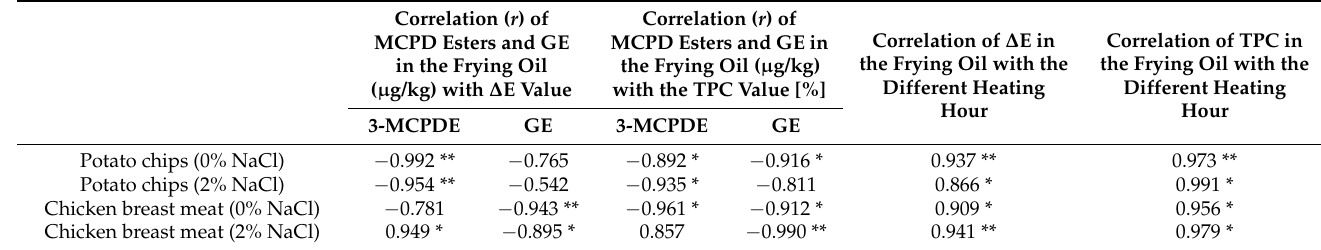
Table 2. Correlation analysis between 3-MCPDE or GE and TPC or ∆ E value. Correlation ( r ) of Correlation ( r ) of MCPD Esters and GE MCPD Esters and GE in the Frying Oil ( µ g/kg) with ∆ E Value